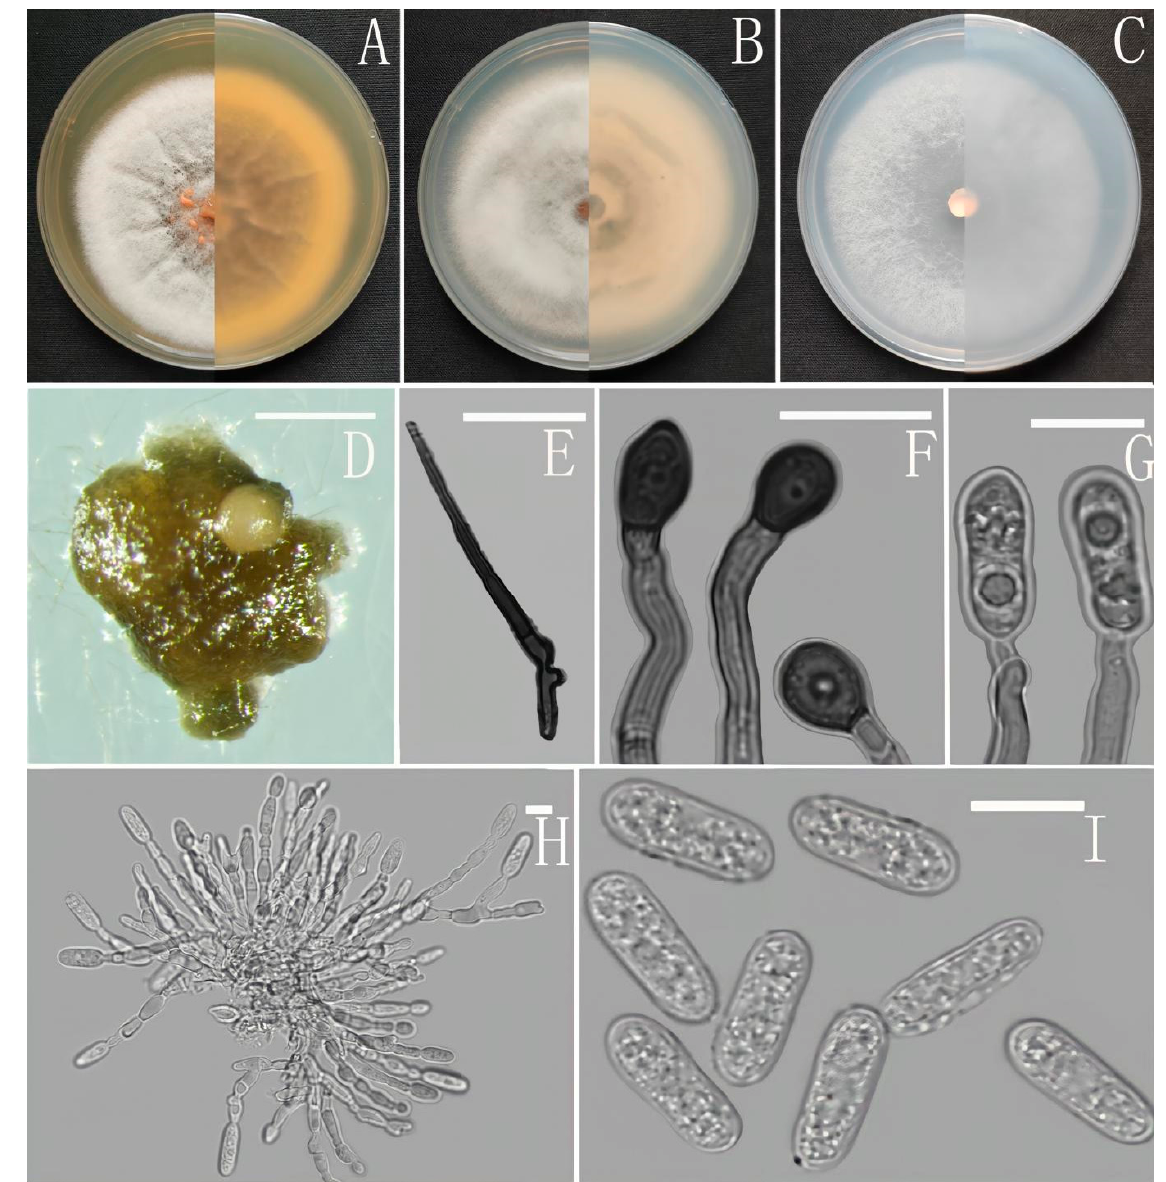
Figure 7. Colletotrichum nanhuaense (YMF1.04993). ( A – C ) Colonies on media above and below after 7 days at 25 °C (( A) MEA; ( B) PDA; ( C) SNA). ( D ) Conidiomata. ( E ) Seta. ( F ) Appressoria. ( G ) Conidiophores. ( H ) Conidiophores and Conidia. ( I ) Conidia. Scale bars: D = 100 μ m, ( E – I ) = 10 μ m.